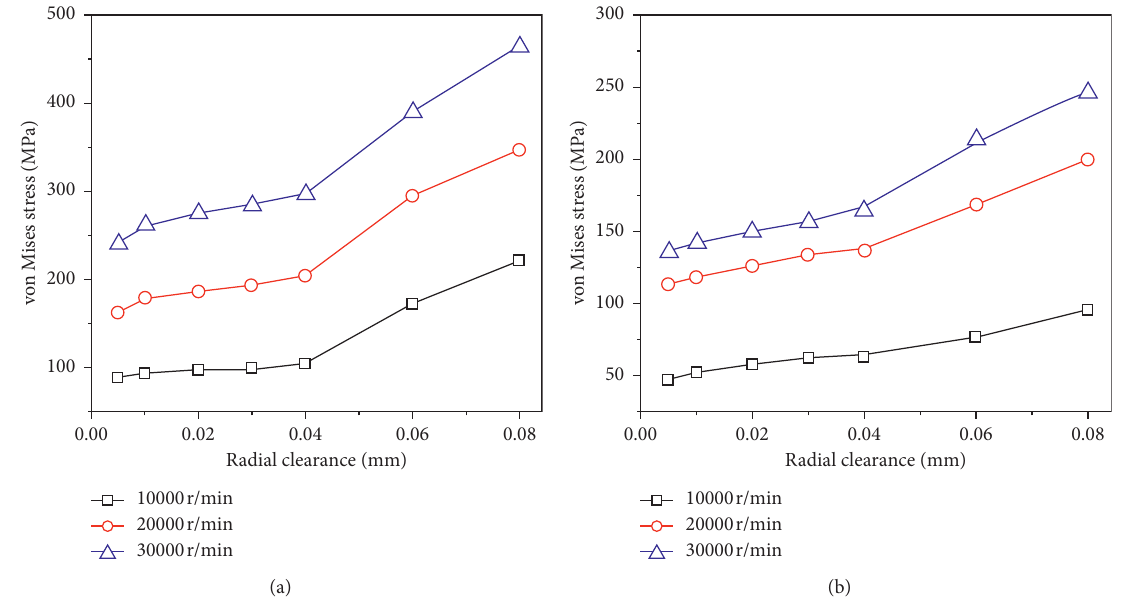
Figure 14: Influence of radial clearance on cage stress at the stage of start-up and stop. (a) Cage stress at the stage of start-up. (b) Cage stress at the stage of stop.